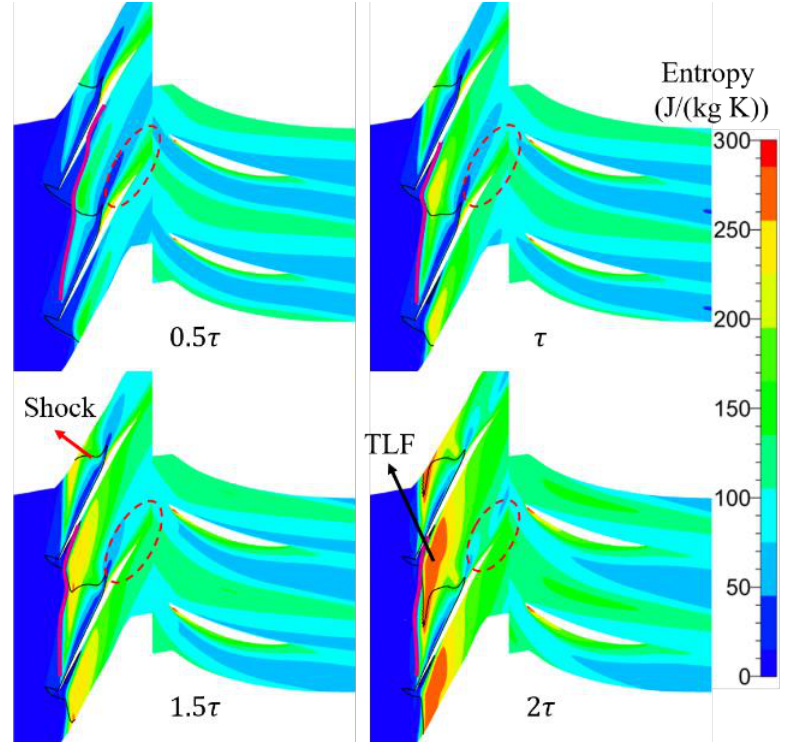
Figure 16. Entropy contours at 98% span of compressors with different rotor tip clearances at P1 .